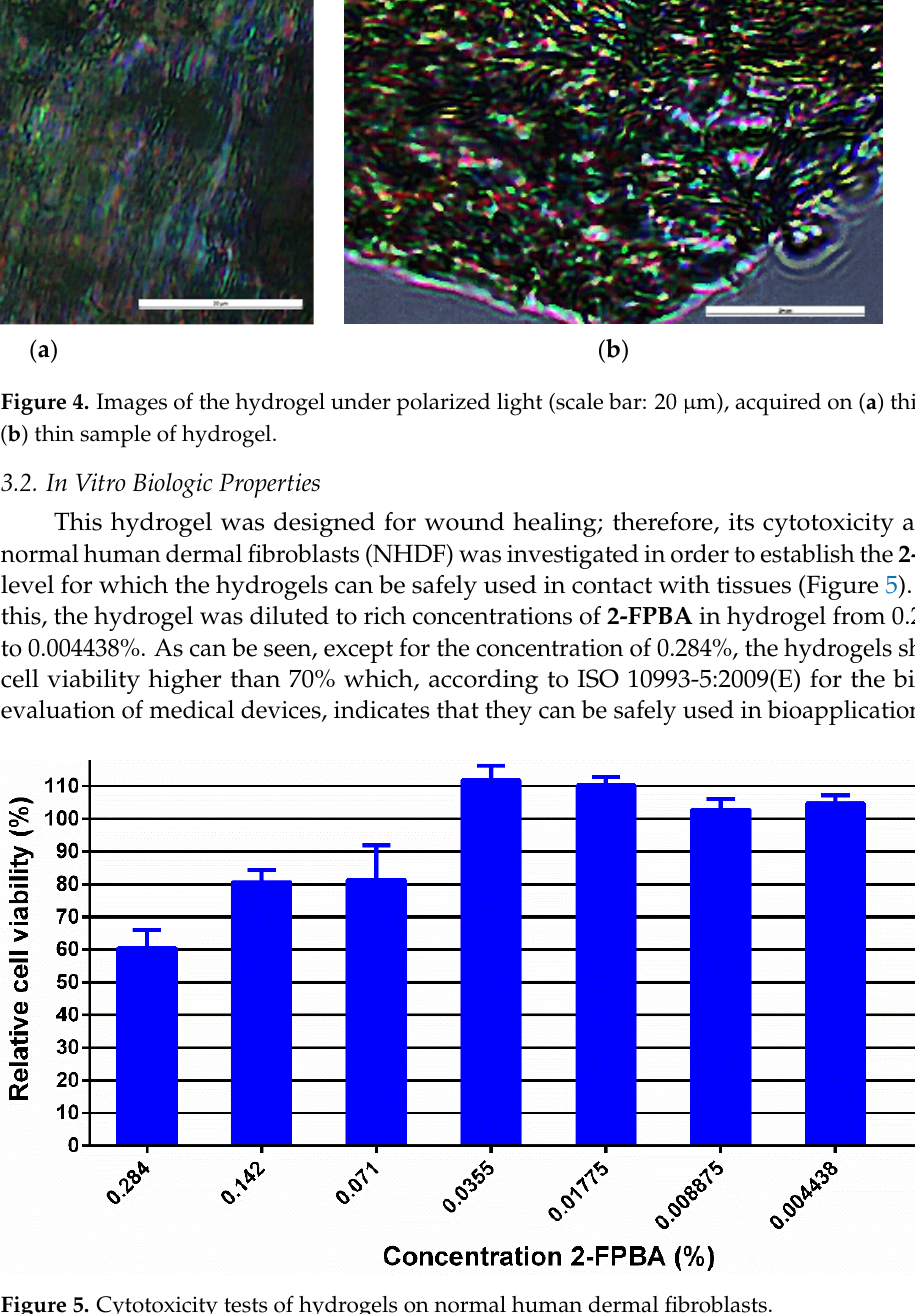
Figure 5. Cytotoxicity tests of hydrogels on normal human dermal fibroblasts.